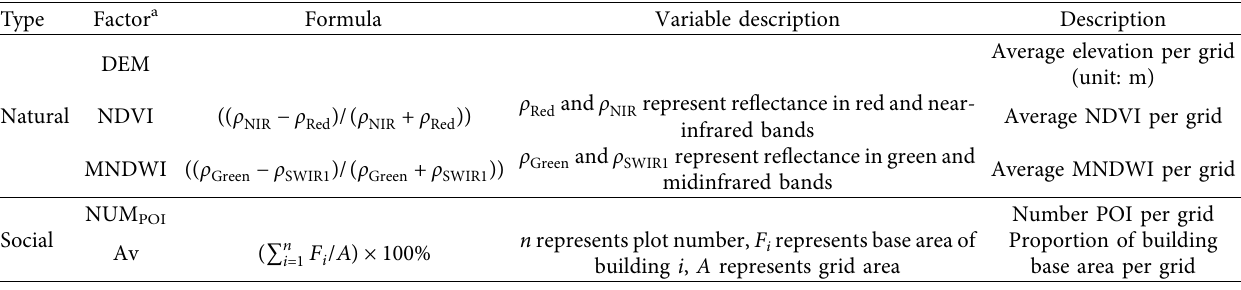
Table 2: Driving factors and